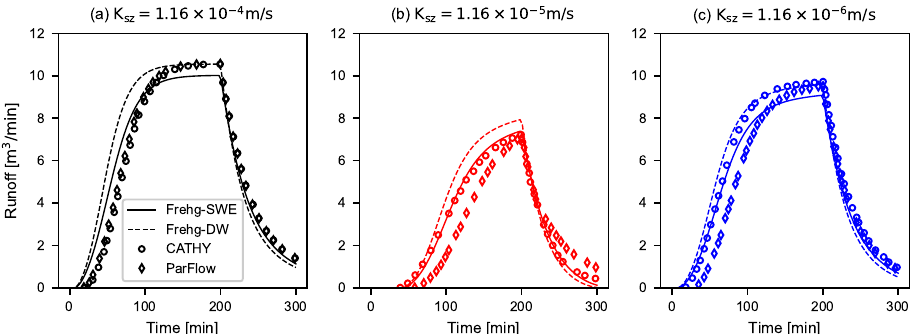
in Figure 3b,c, less runoff is generated despite their small conductivity. In all scenarios, Frehg has good agreements with CATHY and ParFlow in terms of runoff. Compared with solving the SWE, applying the DW approximation leads to slightly higher surface runoff, but the difference between SWE and DW does not exceed the difference between CATHY and ParFlow, indicating both SWE and DW are reasonable methods for this test problem. For Figure 3a,b, the DW method produces the highest flow rate on the rising limb, which is likely due to the asynchronous coupling scheme [46].